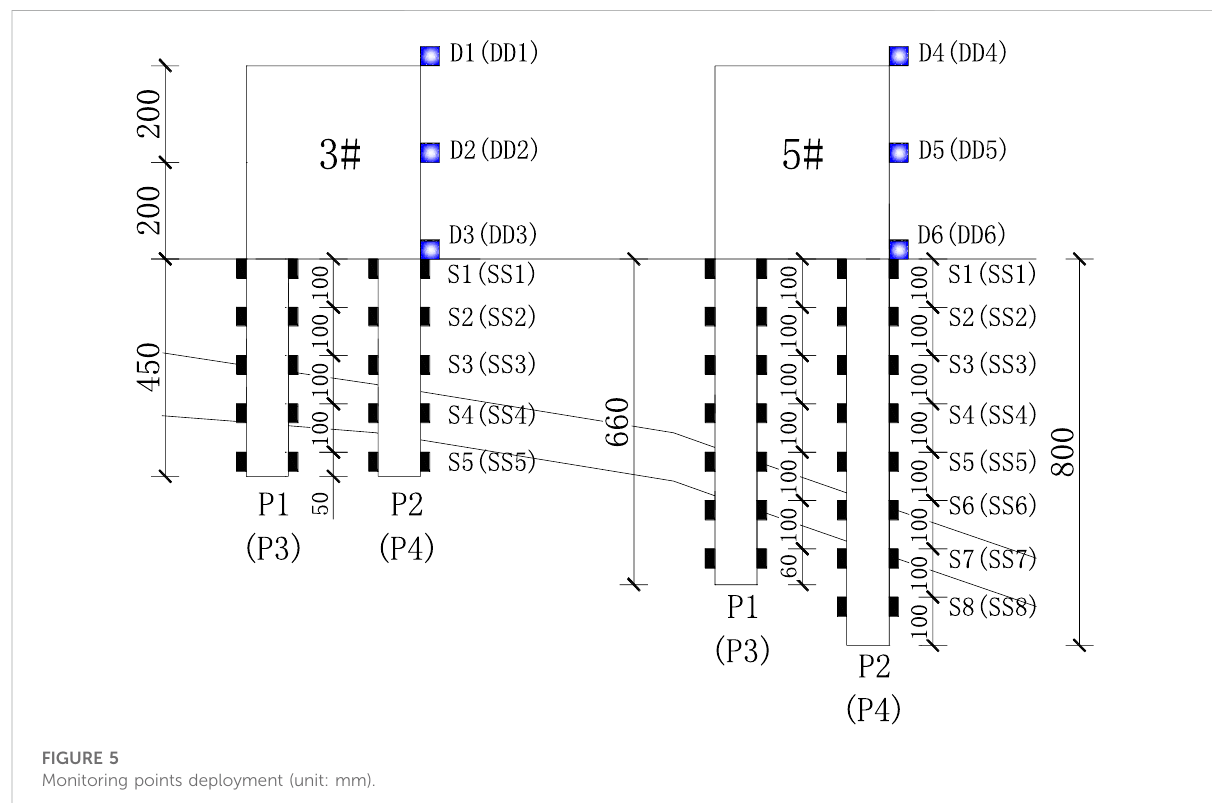
FIGURE 5 Monitoring points deployment (unit: